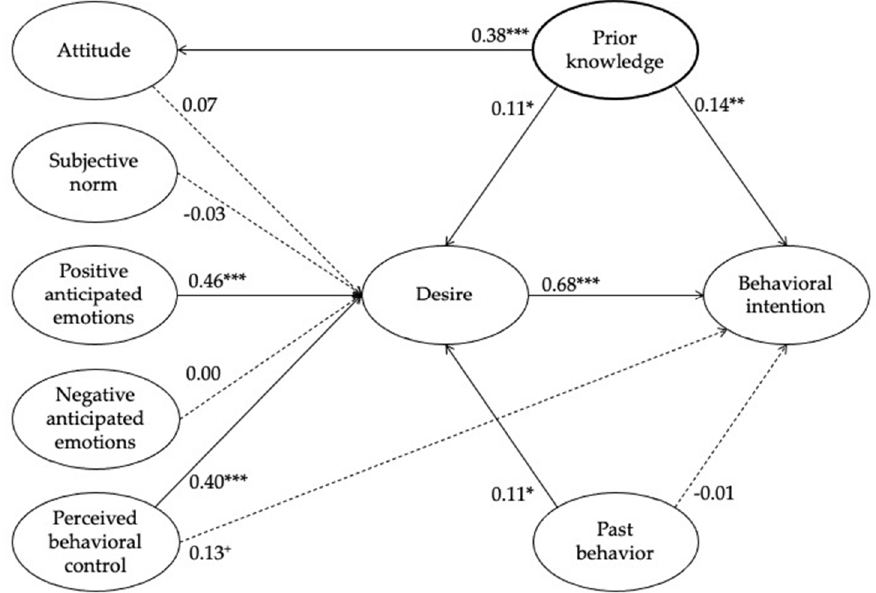
Figure 2. Research model with path coefficients. Note: * p < 0.05, ** p < 0.01, *** p < 0.001, + p < 0.10.